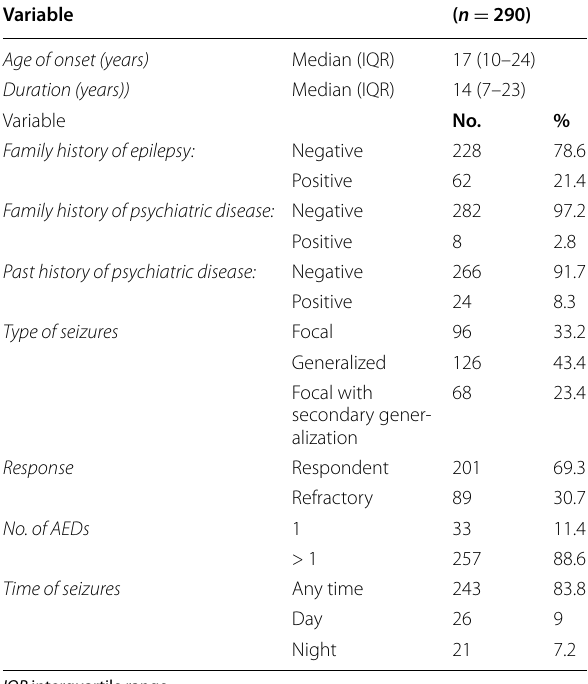
Table 1 Demographic characteristics of the studied group Table 2 Clinical data of epilepsy among the studied group